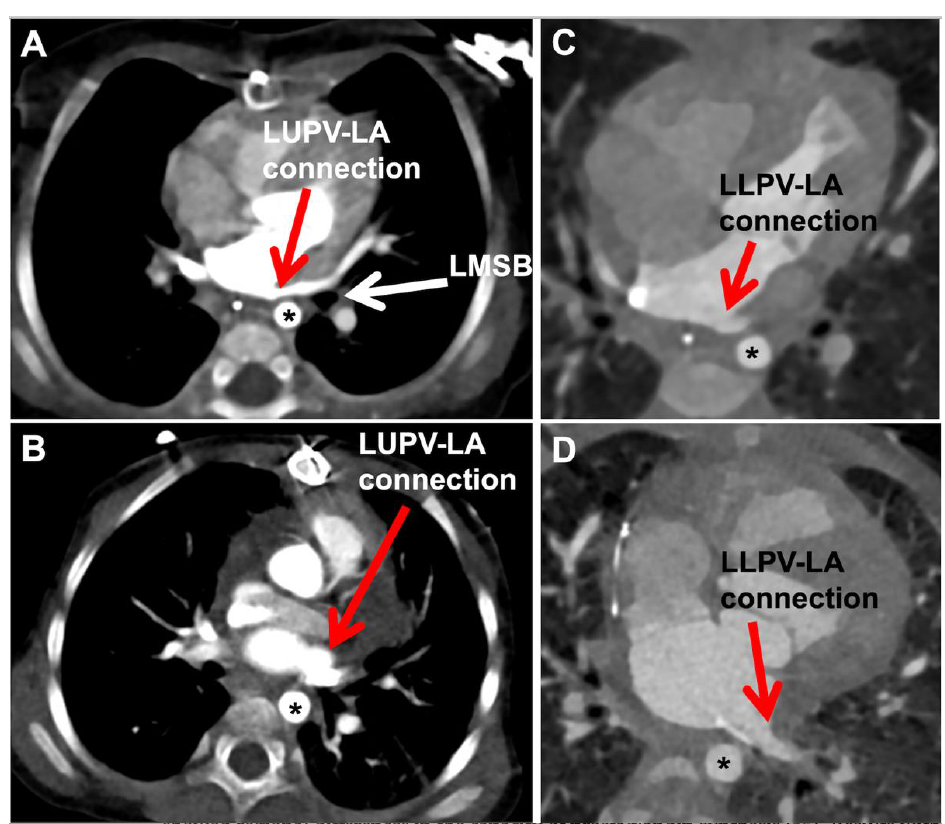
Figure 7. Pre- and post-repair pulmonary vein CT imaging. ( a ) Pre-operative left upper pulmonary vein taking long course over left bronchus before entering medially into left atrium; ( b ) Post-repair left upper vein course is shorter and more lateral — minimizing angulation; ( c ) Pre-operative left lower vein entering left atrium very medially after coursing over descending aorta; ( d ) Post-repair left lower vein takes shorter/straighter course as it enters atrium more laterally. (LUPV – LA = left upper pulmonary vein – left atrium; LMSB = left mainstem bronchus; LLPV – LA = left lower pulmonary vein – left atrium; Asterisk = descending thoracic aorta).